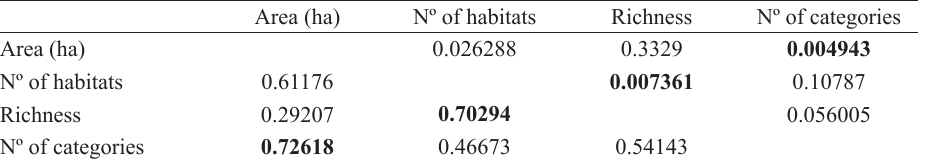
Matrix of correlation between the analyzed variables for the areas inventoried in the MSF, with their respective values of ‘p’ and ‘r²’ (significant values are shown in